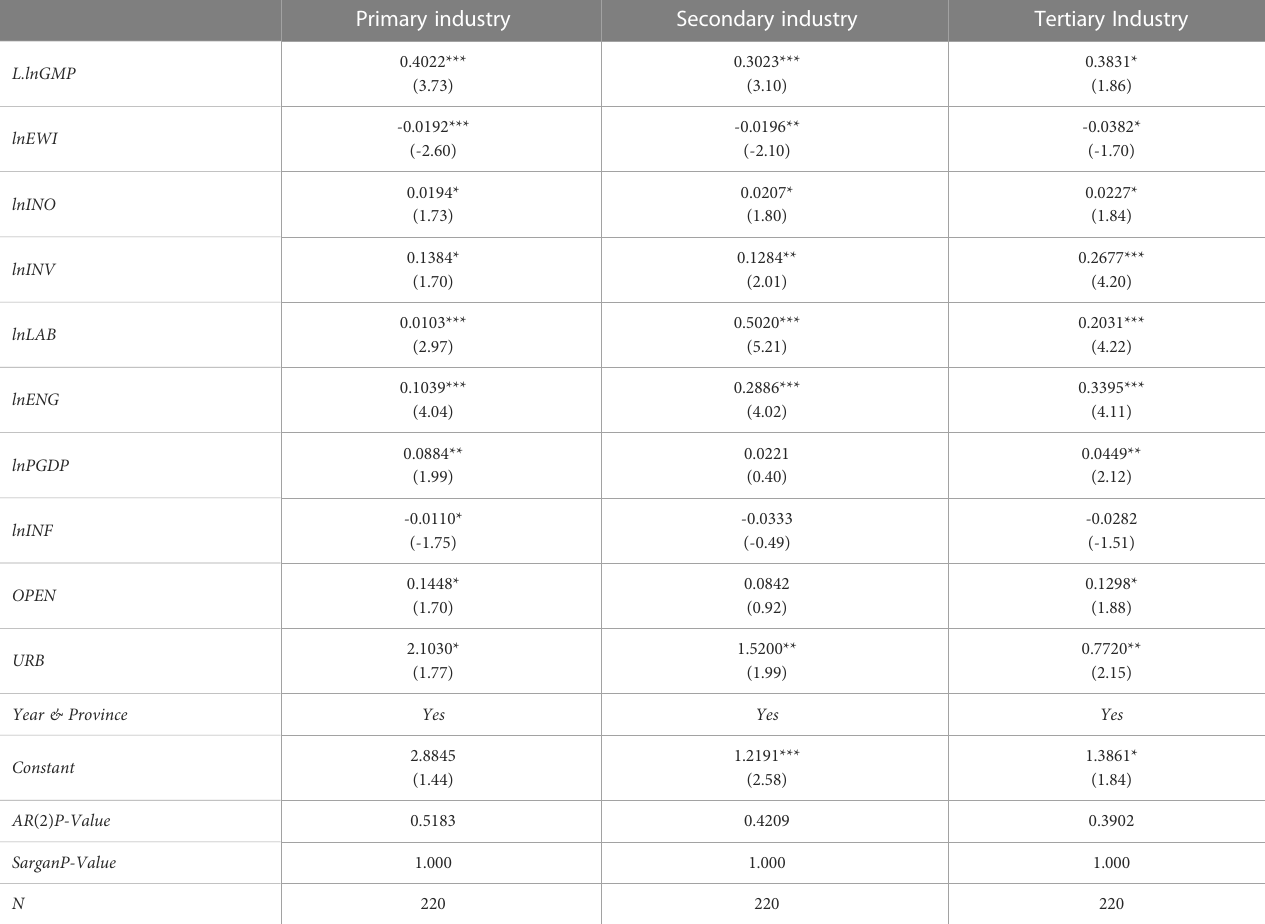
TABLE 4 Heterogeneity analysis of marine